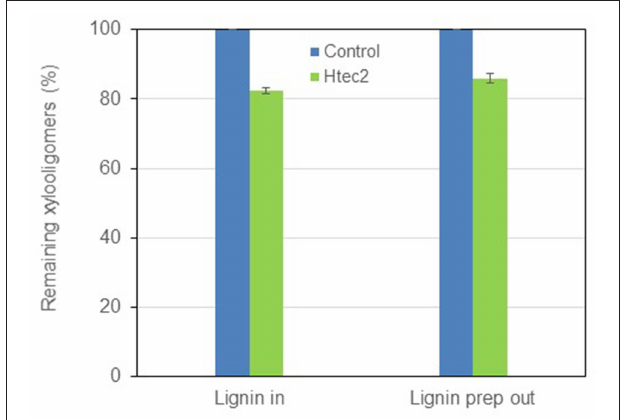
FIGURE 6 | Xylooligomer degradation in black liquor after lignin precipitated out.